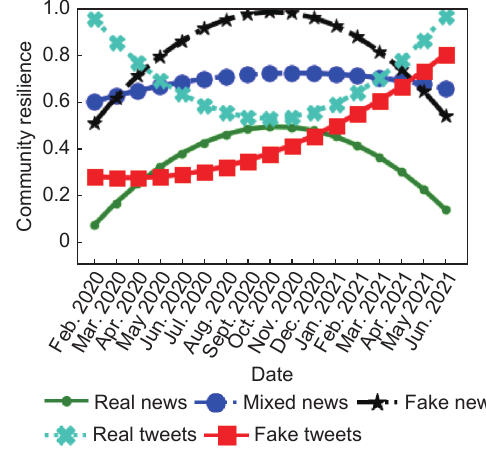
Fig. 8 Output-oriented analysis of community resilience measured based on different types of news and tweets for Feb.